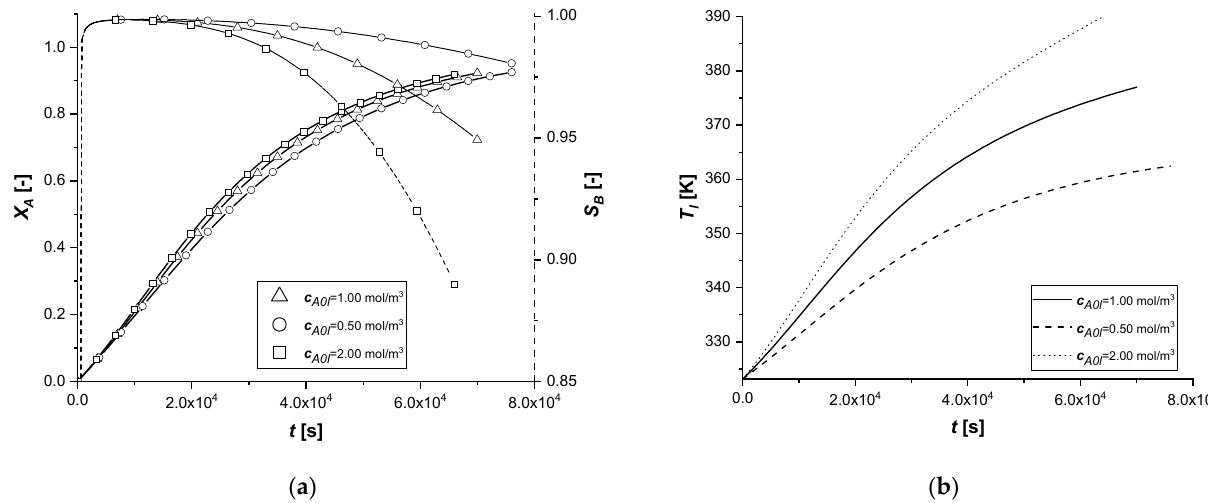
Figure 27. EW c A 0,l investigation. ( a ) Bulk profiles over time of X A and S B . ( b ) Bulk profile of T l over time.